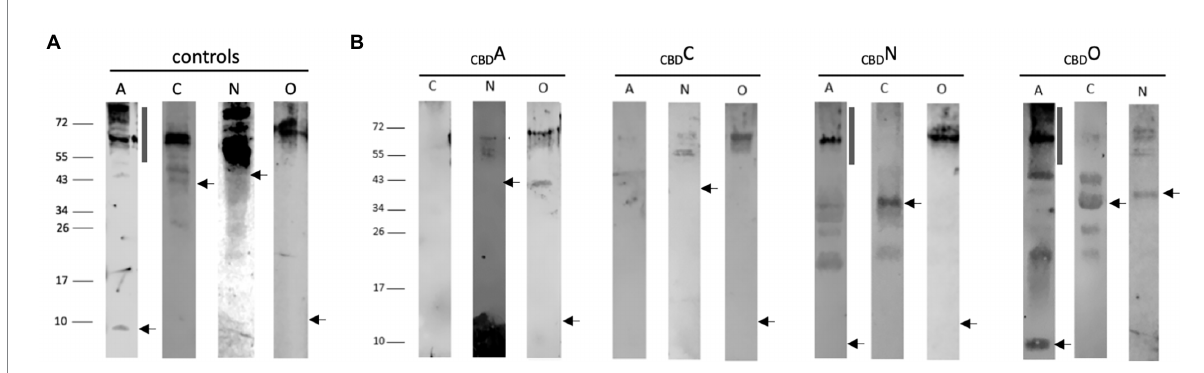
FIGURE 2 Western analyses of the pulldown assays using CBD A, CBD C, CBD N, or CBD O. In each case, 15 μ l of the elution sample was separated by SDS-PAGE, the proteins were transferred to a PVDF membrane, incubated with the respective antiserum, and visualized by the fluorophore-labeled secondary antibody IRDye 800 CW (Licor). The blots are inverted to black-white. Numbers on the left indicate sizes in kDa. (A) Western analysis of Hfx. volcanii transformants producing the GvpA, C, N, or O used as control. The apparent masses of the protein monomers are 8.0 kDa, GvpA; 42.3 kDa, GvpC; 39.0 kDa, GvpN, and 13.2 kDa, GvpO. The position of the respective monomer is indicated by an arrow. The vertical bar in the panel of GvpA marks the position of multimers formed by this hydrophobic protein. (B) Western analysis of Hfx. volcanii CBD X/Y transformants (X, Y = A, C, N, or O) containing the CBD-tagged bait protein plus one of the other three proteins as prey is indicated by the letter on top of each blot. Only the elution fraction of the cellulose matrix is shown. In each case, the arrow marks the position of the respective Gvp monomer, and the vertical bar the position of GvpA multimers.